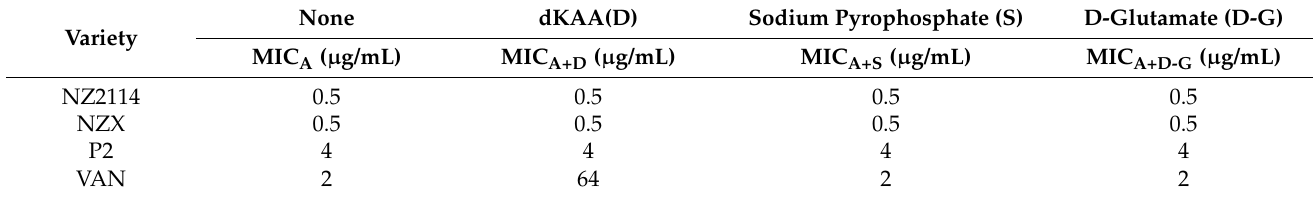
Table 4. The effect of lipid II analogues on the antibacterial activity of peptides.